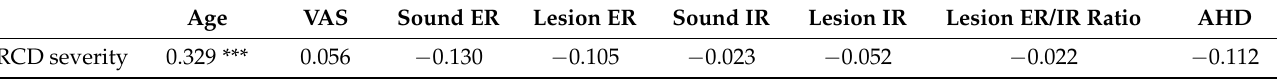
Table 3. Pearson’s correlation coefficients between RCD and each factor ( n = 102).